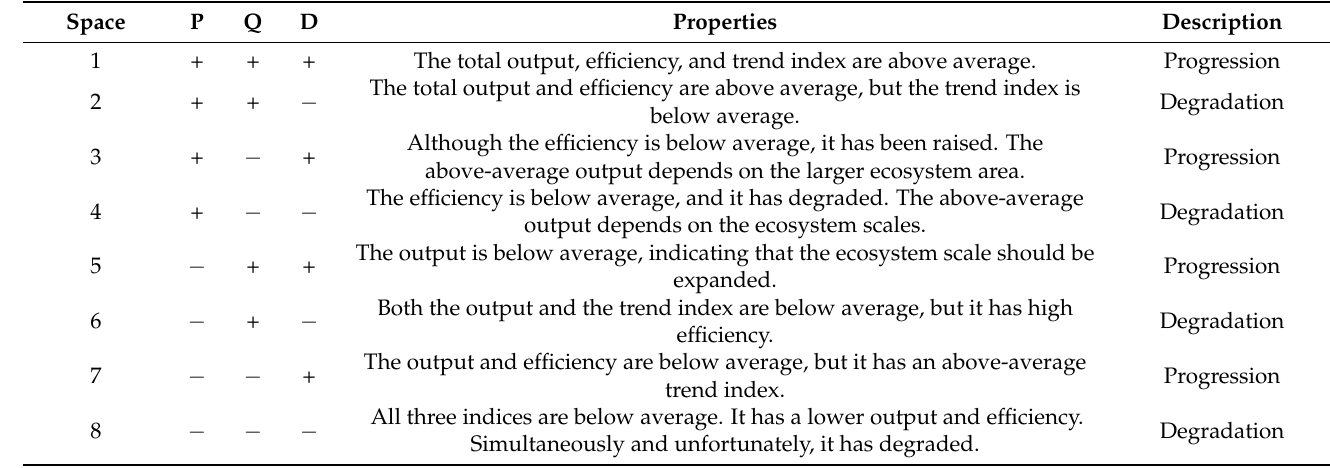
Table 3. Multidimensional assessment spaces and their